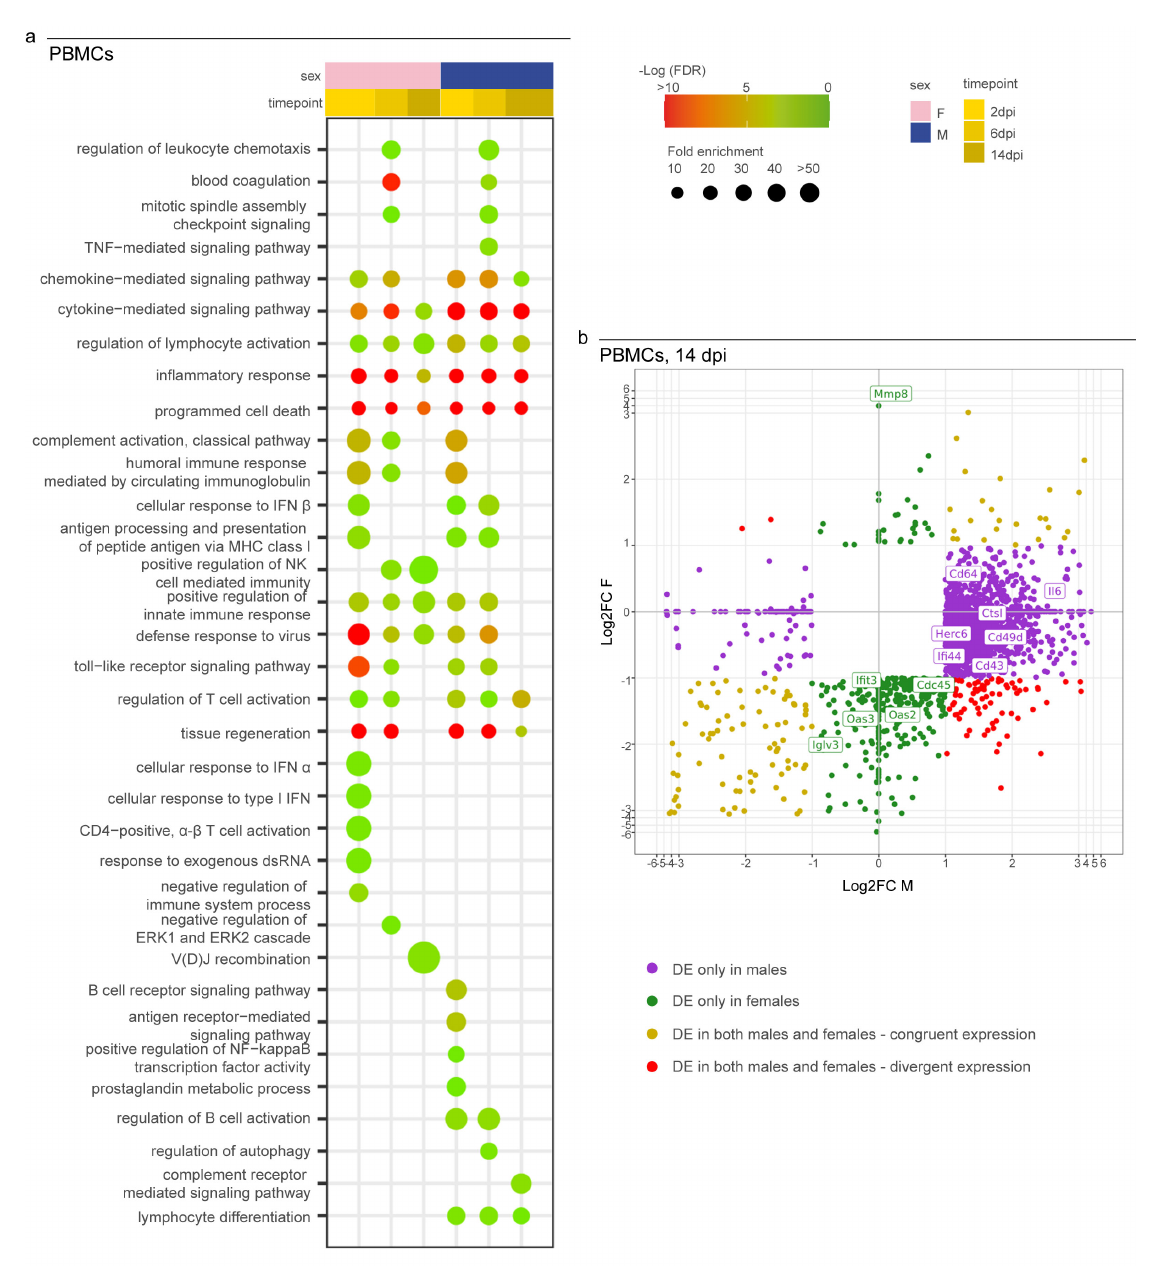
Figure 5. Transcriptomic profile of SARS-CoV-2-infected male and female PBMCs. ( a ) Dotplot representing the most specific enriched GO terms related to immunity in PBMCs. Statistically significant enrichments (FDR < 0.05) are presented, and the − LogFDR is shown. ( b ) Scatterplot representing the Log2FC of male and female DEGs in PBMCs at 14 dpi. DE = differentially expressed. A DEG was significant in a comparison when Log2FC ≤ − 1 or Log2FC ≥ 1and FDR < 0.05. The absence of the dot means that the indicated GO term was not enriched in that particular sample.